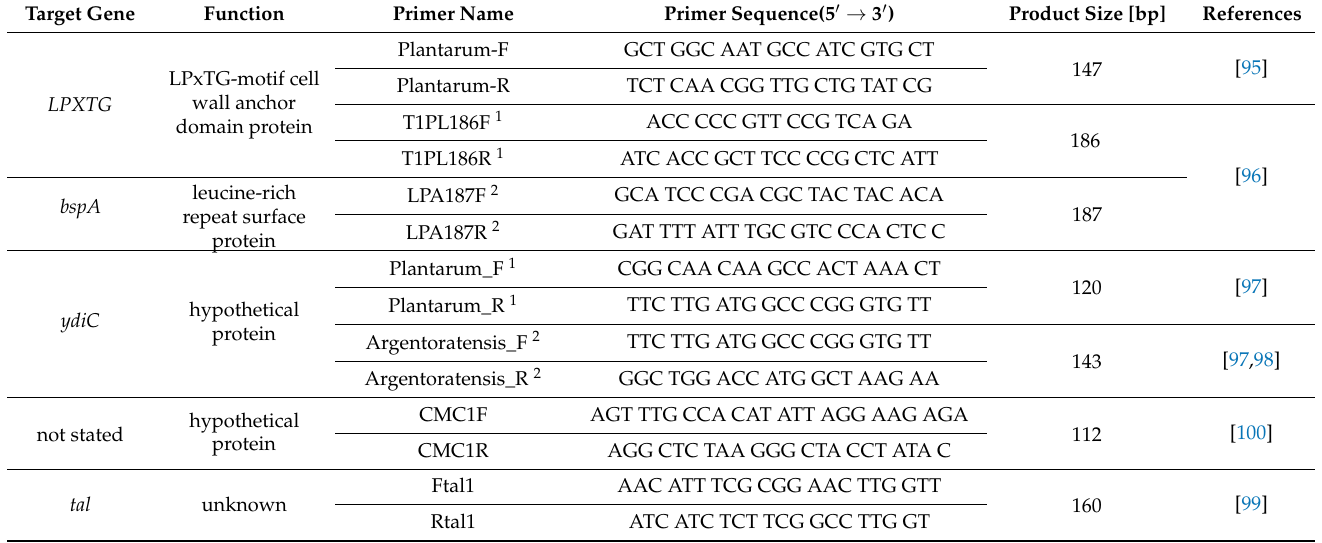
Table 3. L. plantarum species and subspecies-specific qPCR